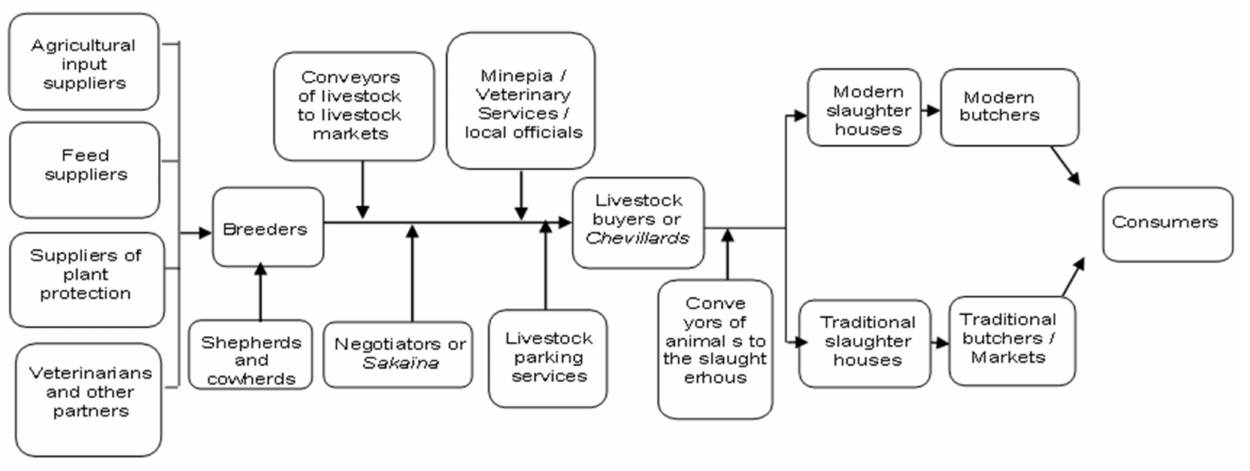
Figure 1. The actors of the meat supply chain in